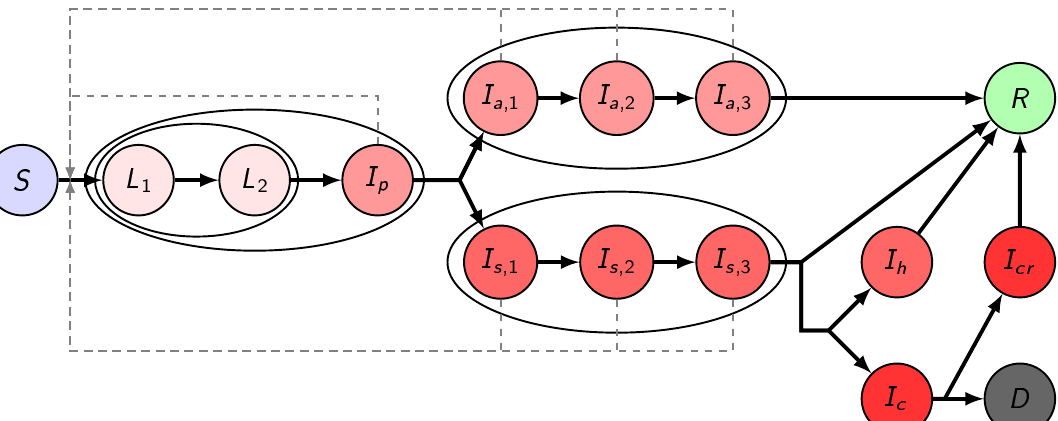
Figure 1. Transmission diagram. Different shades of red denote infected compartments. A darker shade corresponds to a more severe state of the disease: those in compartments with the lightest shade do not transmit the disease, those in compartments with the darkest shade are in critical status. Black solid arrows denote the possible ways of transition from one compartment to another. Gray dashed arrows show possible ways of infection. Compartments being grouped together in ellipses stand for different stages of the same